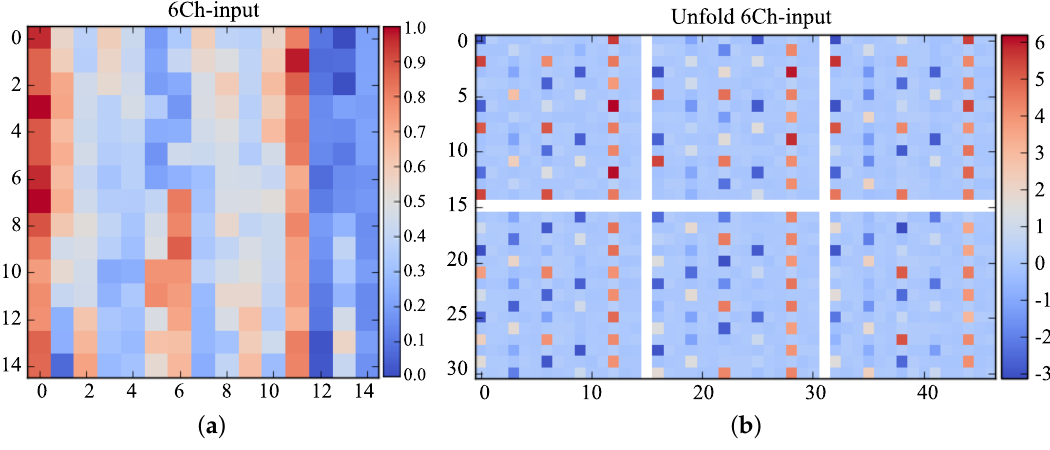
Figure 12. ( a ) Mixed visualized image of the 6Ch-input; ( b ) Unfolded visualized images of the